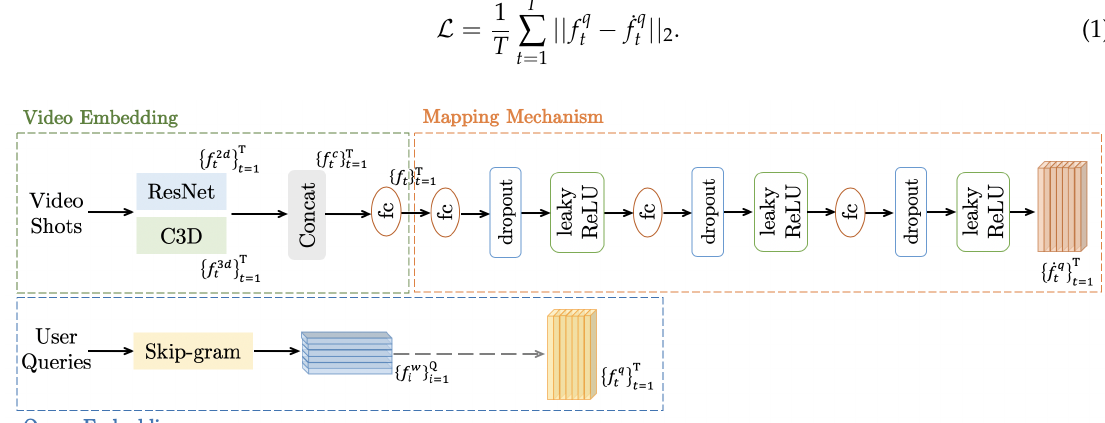
Figure 2. The architecture of our proposed Mapping Network (MapNet) has two branches. (1) Video shots are encoded using a ResNet and a C3D model to generate 2D/3D visual features { f 2 d } T and { f 3 d . After down-sampling, the visual features are fused through concatenation ( { f c t t = 1 followed by a fc layer to get { f t } T as a video embedding. Then three groups of fc layers, dropout t = 1 layers and leaky ReLUs are used to map the video shots embeddings to the predicted query embeddings { ˙ f q } T . (2) Different user queries each consists of two concepts are encoded via a Skip-gram model to t t = 1 } T generate query embedding { f w . The combined whole-query embedding { f q t = 1 i by averaging over all queries for each video shot. MapNet is trained to predict { ˙ f q } T to { f q t t = 1